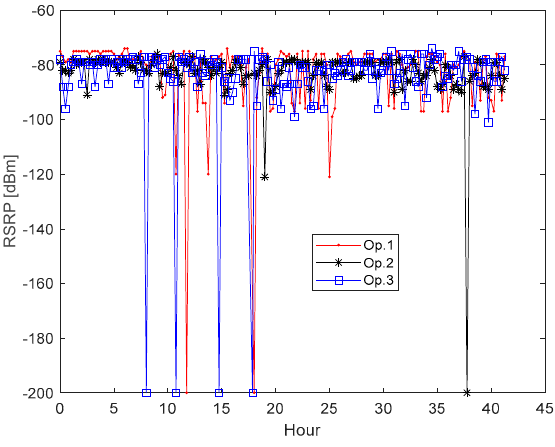
Figure 7. Measured RSRP for 4G-LTE at probe A.